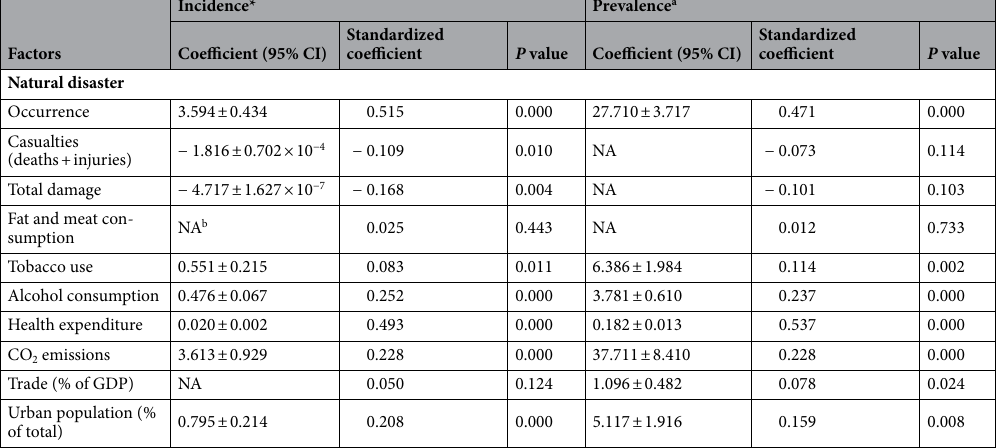
Table 3. Multivariable linear regression-derived coefficients for natural disaster and socioeconomic variables for the incidence and prevalence of ischemic stroke in males from 1990 to 2017 in 193 countries, weighted by population. *The stepwise method was used, R 2 = 0.829, F = 110.674, p = 0.000. a The stepwise method was used, R 2 = 0.795, F = 101.269, p = 0.000. b Not applicable for variables not included as predictors.